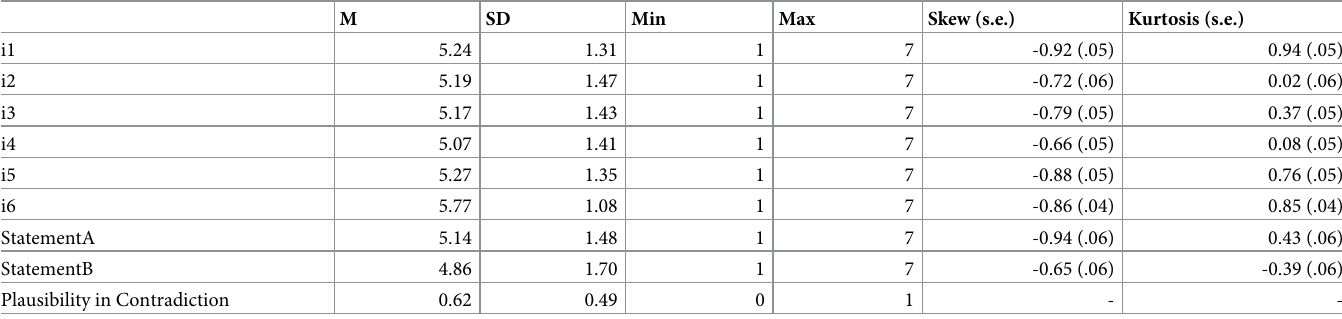
Table 1. Descriptive statistics of the variables from Study 1.